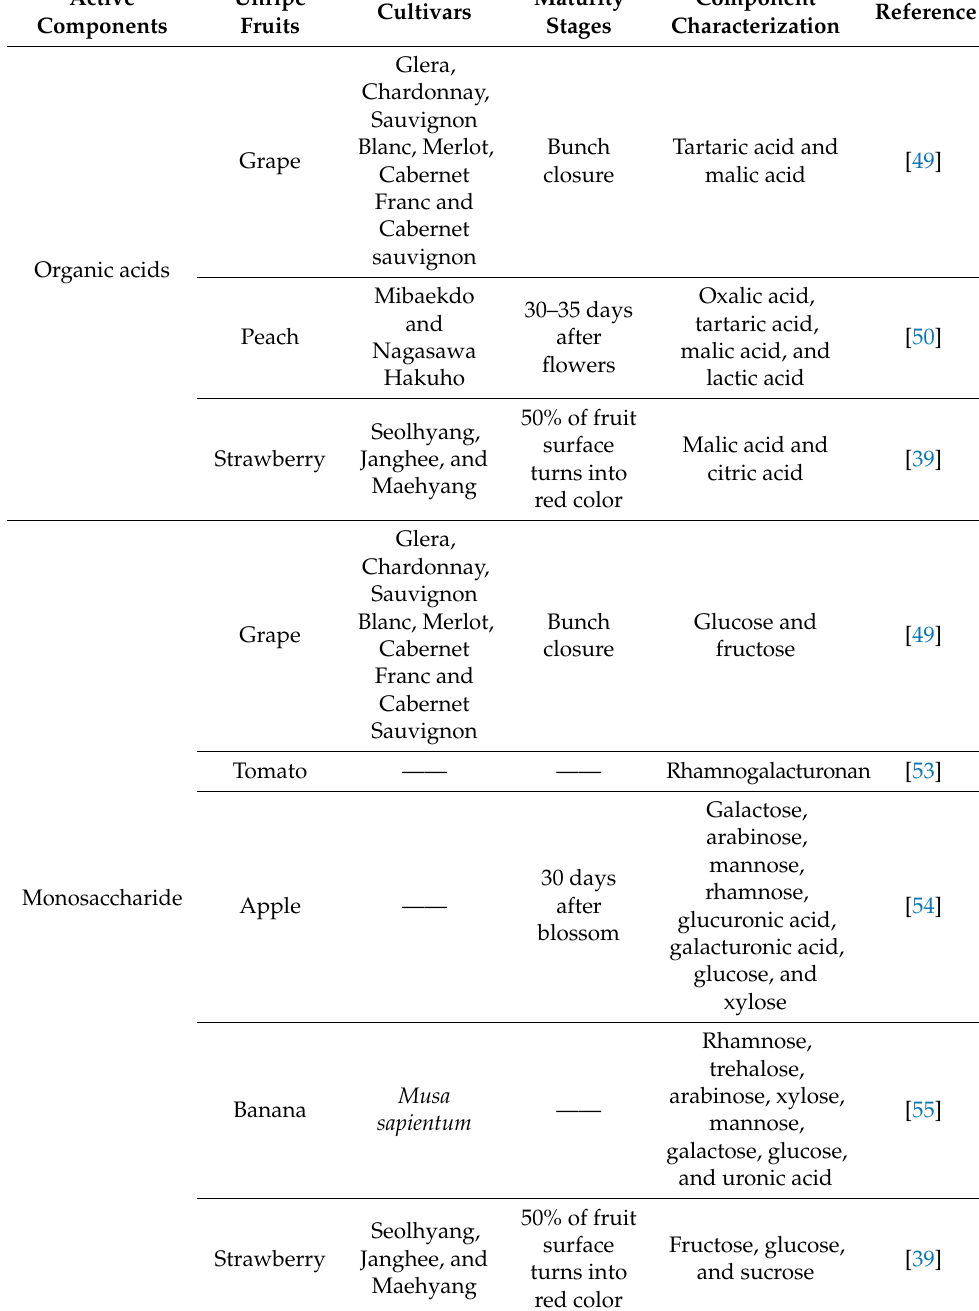
Table 3. Organic acids and monosaccharides in unripe